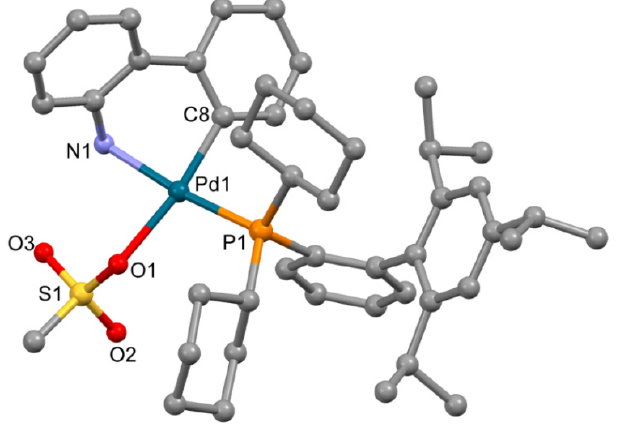
Figure 3. Molecular structure of 3a . Noncoordinated ethylacetate is now shown. Thermal ellipsoids are shown at 0.15 probability level. H atoms are omitted for clarity.